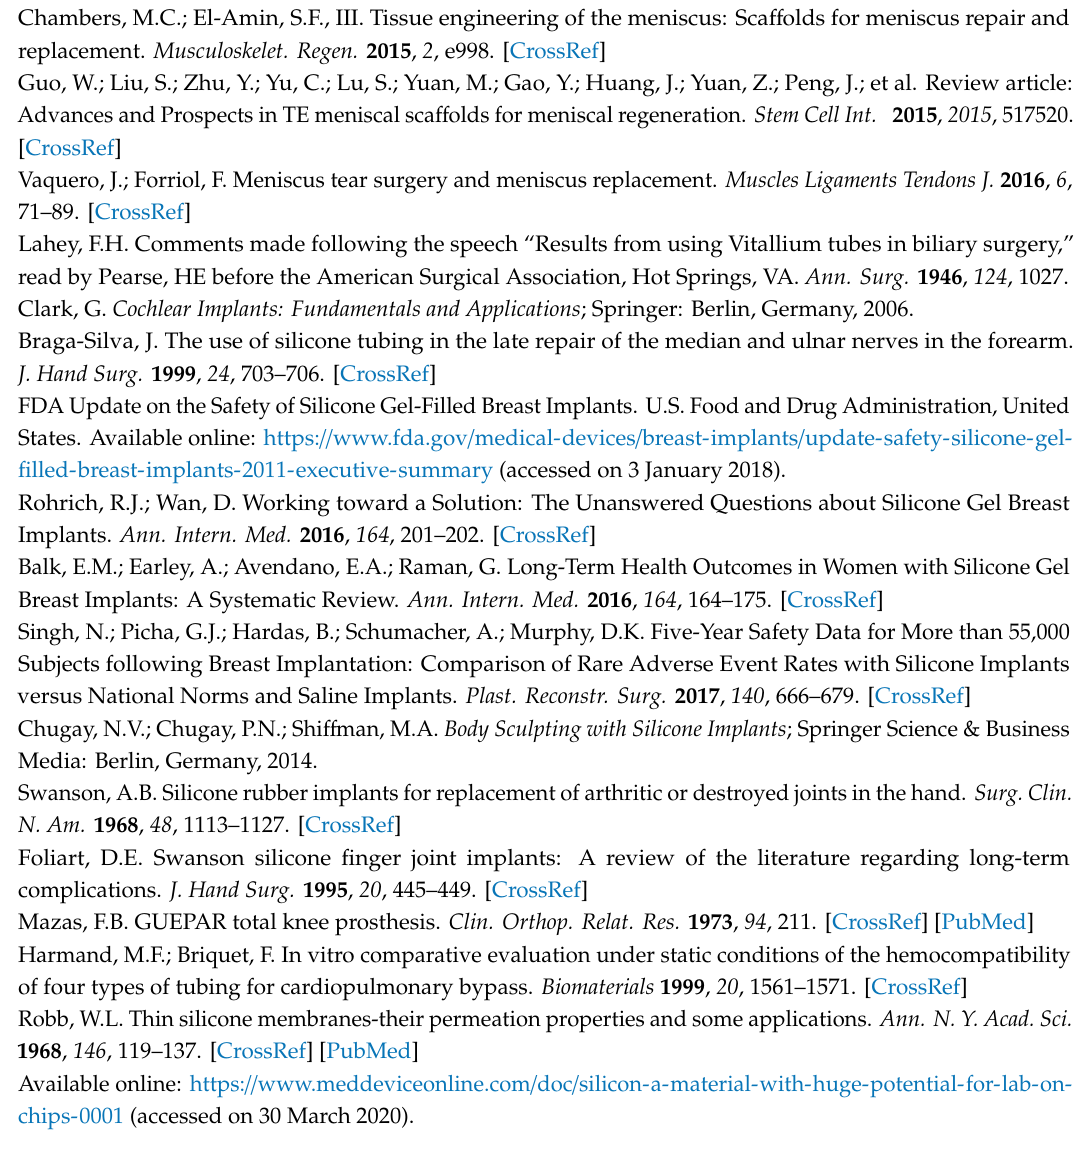
Figure S3. Bright field images of (a) topmost layer and (b) vertical cross-section of body of 3D printed silicone meniscus implant. Figure S4.. Comparison of thermal results using one-convection (above) and on-o ff (below) simulation. Table S1. Material Properties of Aluminum, Stainless Steel 304, Ecoflex Silicone. Table S2. Boundary conditions for printed silicone meniscus implant.) and on-o ff (below)